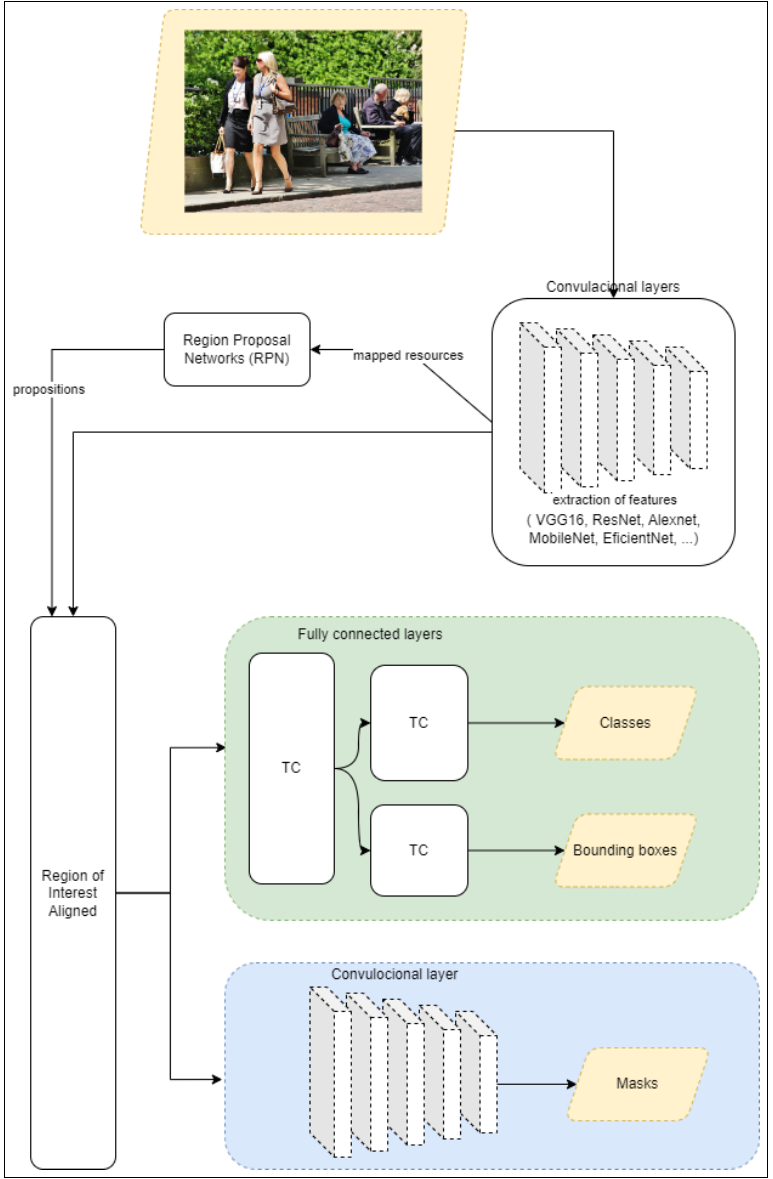
Figure 2. Architecture diagram of Mask